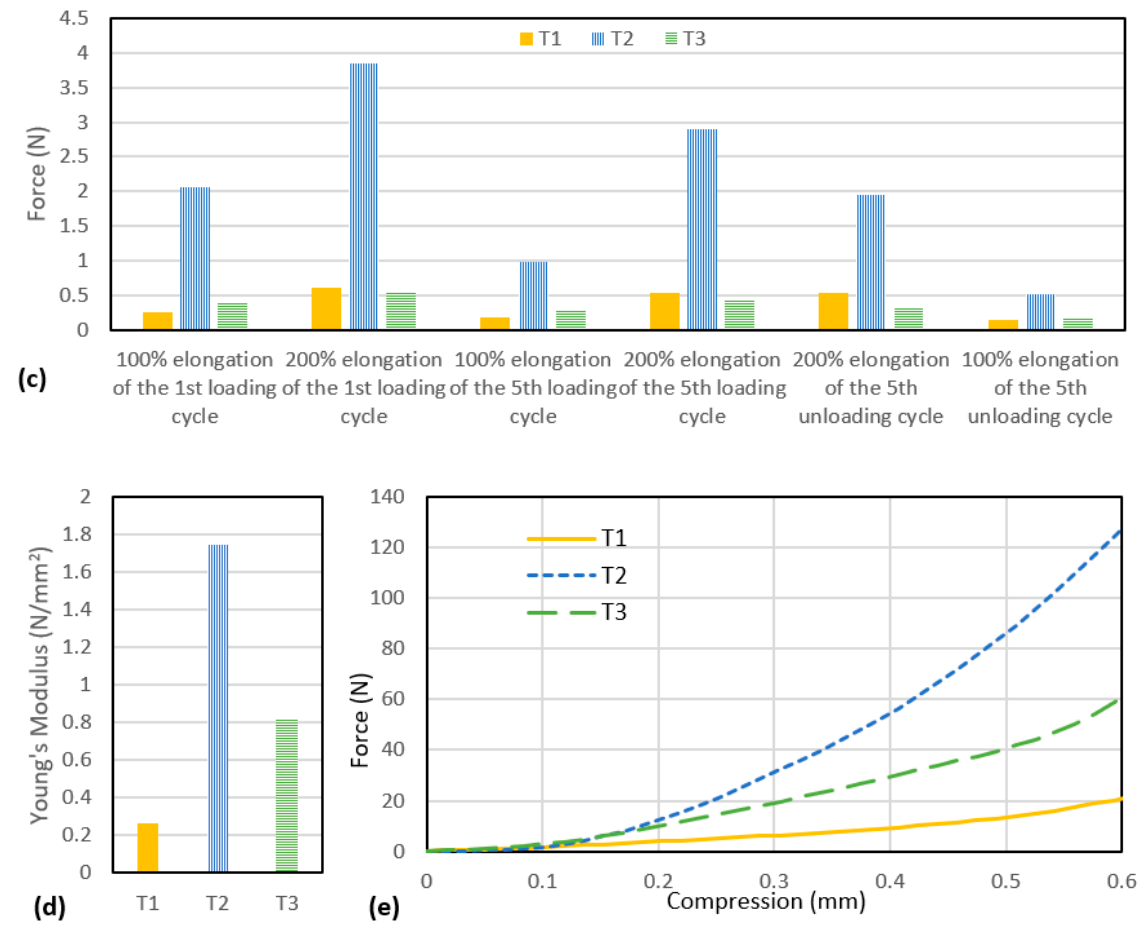
Figure 3. Tensile extension–force curves for ( a ) the first cycle of extension, and ( b ) the fifth cycle of extension; ( c ) force for 100% and 200% elongation; ( d ) Young’s modulus, and ( e ) compression displacement–force curves of the three tubular samples.